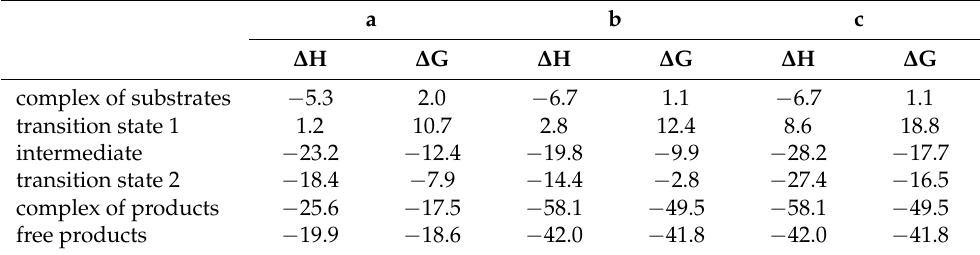
Table 5. Free energies relative to the sum of the free energies of free substrates for the reaction of cis - 6 ( F ) with OH − .